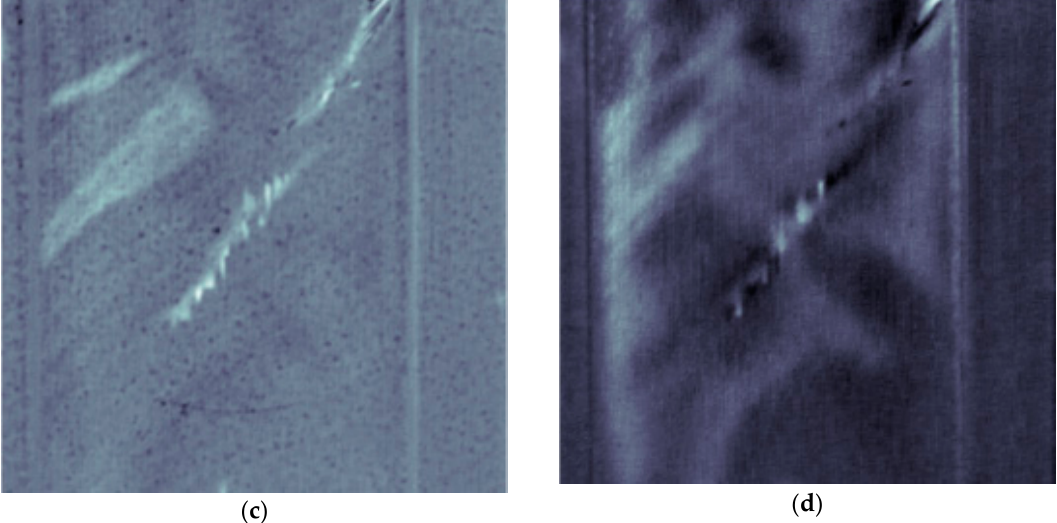
Figure 12. Examples of reconstructed structural images (archetypes) for a damaged composite plate: ( a ) points chosen for “defect #1”; ( b ) points chosen for “defect #2”; ( c ) reconstructed “defect #1”; ( d ) reconstructed “defect #2”.